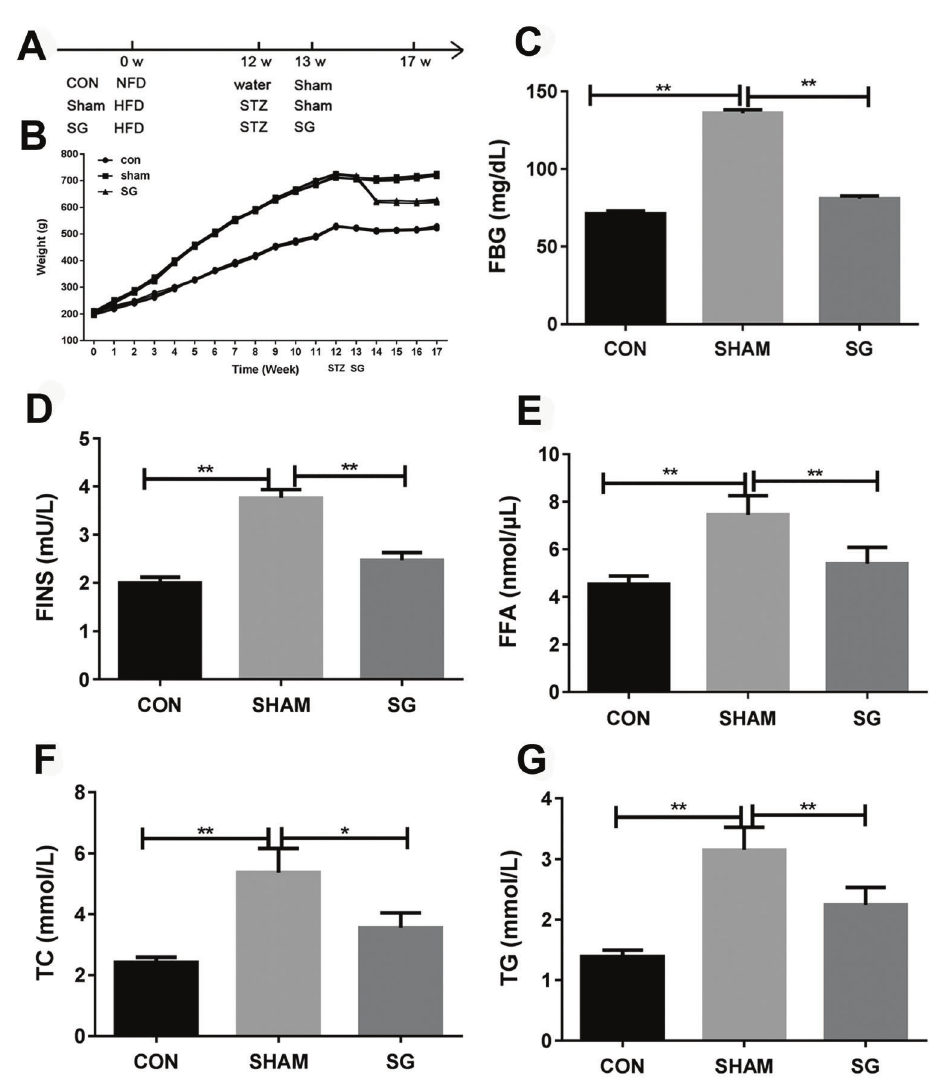
Figure 1 . A , Experimental scheme and B , body weights of sleeve gastrectomy (SG), Sham, and control (CON) groups. Diabetes mellitus was established by combination of high-fat diet (HFD) and streptozotocin (STZ). SG and sham surgery were performed on diabetes mellitus rats. Rats fed with a normal-fat diet (NFD) and that underwent sham surgery were used as the control. C , Fasting blood glucose (FBG); D , fasting insulin (FINS); E , free fatty acid (FFA); F, total cholesterol (TC); G , triglyceride (TG). Data are reported as means ± SD. *P o 0.05, **P o 0.01 ( t